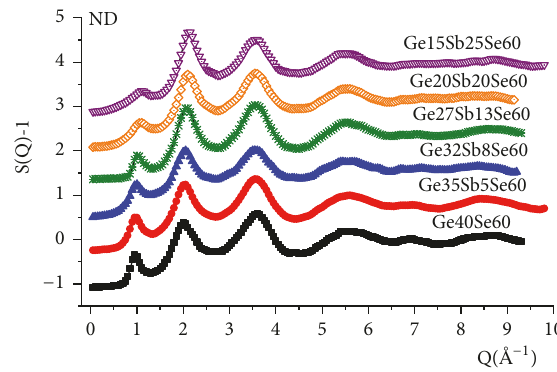
Figure 1: Neutron diffraction structure factor, S ( Q ), of the chalco- genide samples with composition of Ge x Sb 40 20, 15 at.%)is displayed: experimentaldata (colour marks) and RMC simulation (solid lines). For better clarity, the curves are shifted